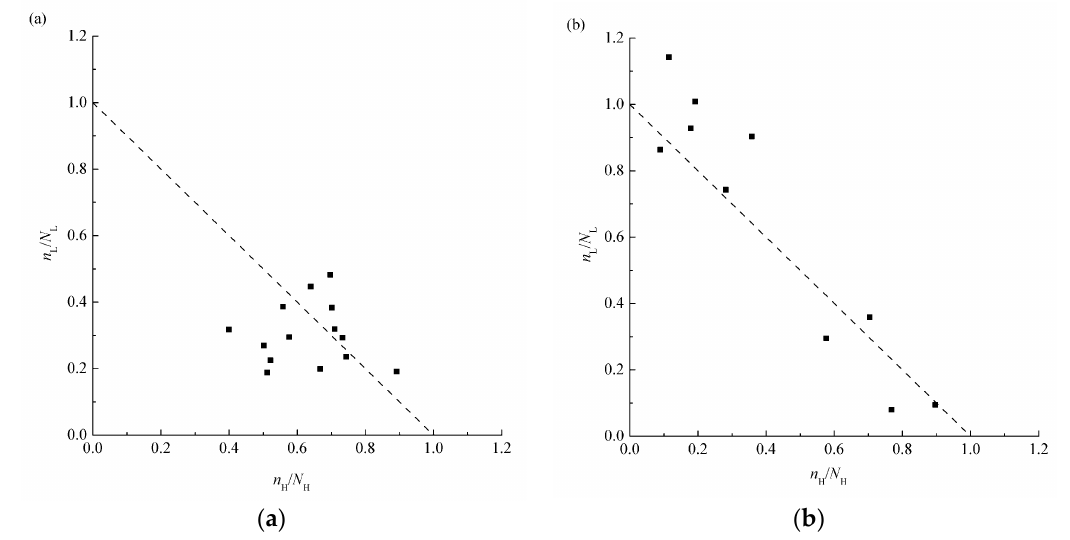
Figure 9. Test results of the damage fractions under ( a ) n L / n H = 1 and ( b ) Δ σ = 59 MPa.